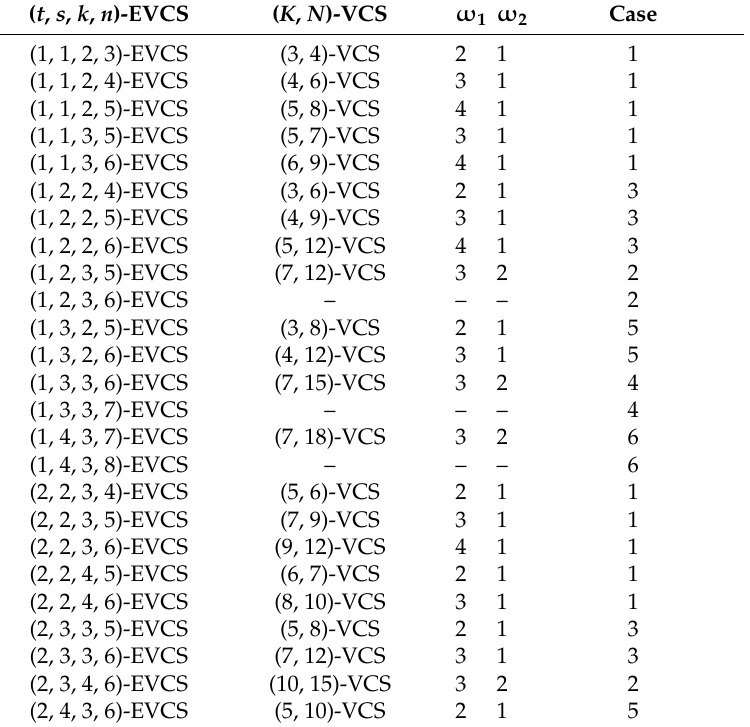
Table 8. The solutions of IPM for some specific essential participants